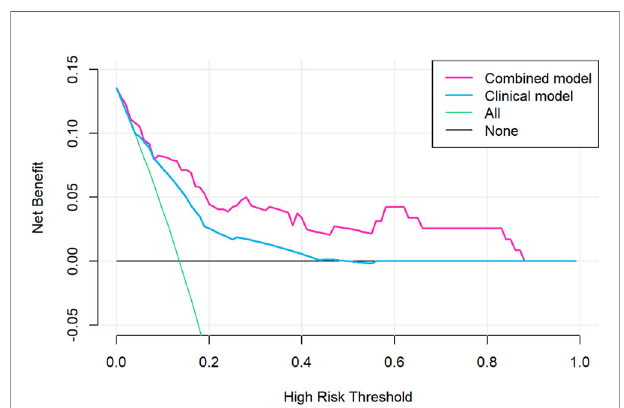
FIGURE 5 | Decision curve analysis for the sarcopenic nomogram. The y-axis measures the net bene fi t. The red line represents the sarcopenic nomogram. The grey line represents the assumption that no patients had risk for progressive disease (PD) and the thin black line represented all patients would develop